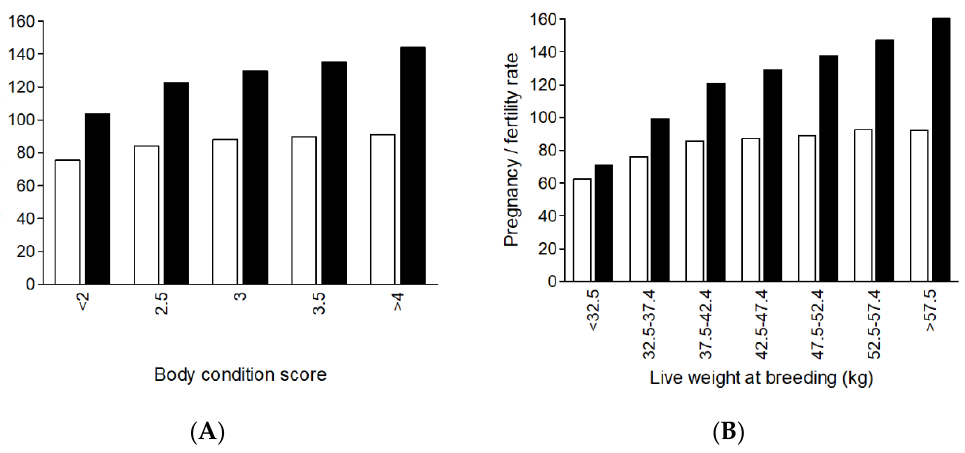
Figure 2. The effect of ewe lamb body condition score ( A ) and breeding liveweight category ( B ) on ewe lamb fertility rate (ewes pregnant per 100 ewes presented for breeding; white bars) and reproductive rate (number of fetuses per 100 ewes presented for breeding; black bars). Adapted from [17] .